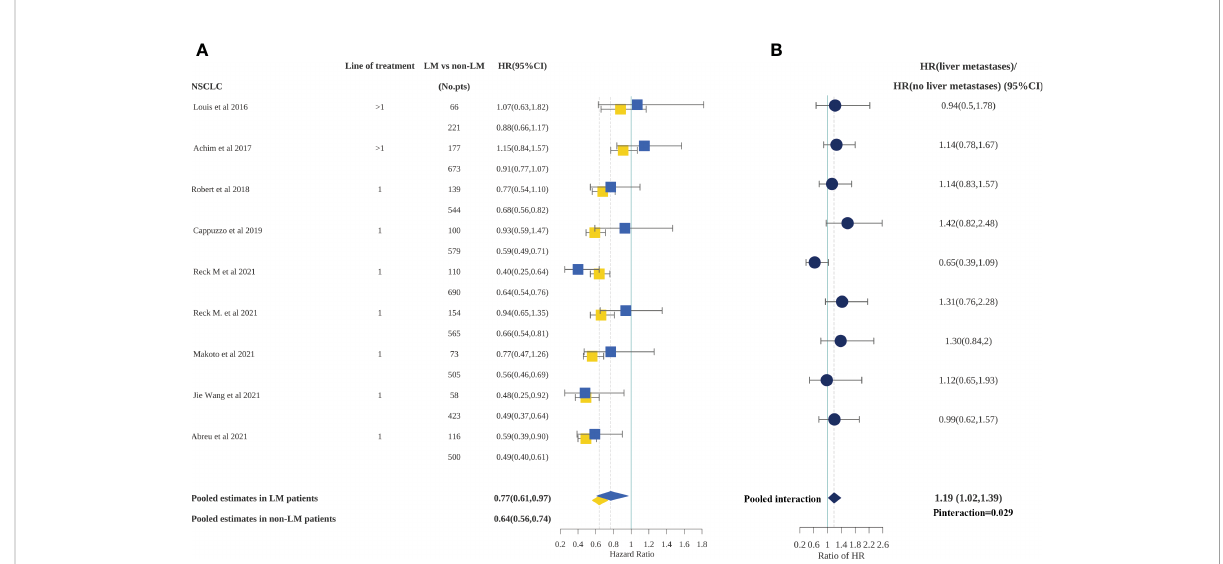
FIGURE 2 Forest plot of hazard ratios for PFS according to liver metastases in non-small cell lung cancer patients. (A) , Hazard Ratios for PFS when comparing immunotherapy to control treatment. (B) , The interaction between PFS bene fi t of immunotherapy and liver metastases.